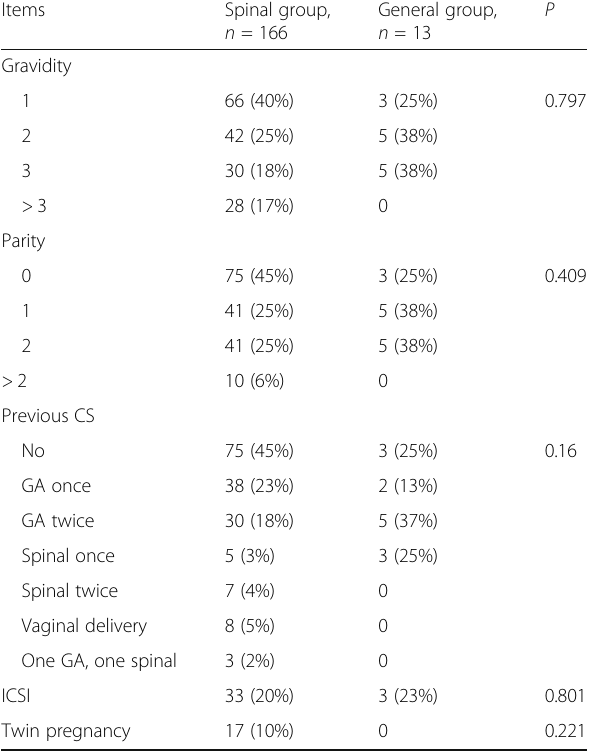
Table 2 The obstetric data according to the primary decision